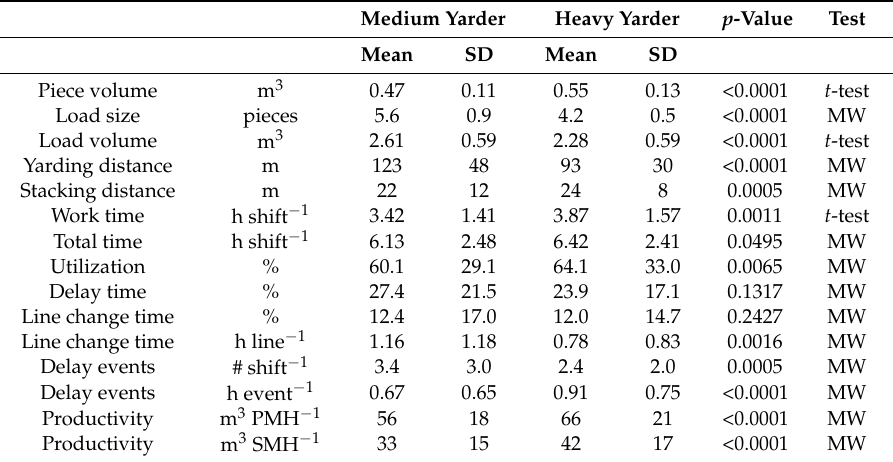
Table 4. Comparison between medium and heavy grapple yarder